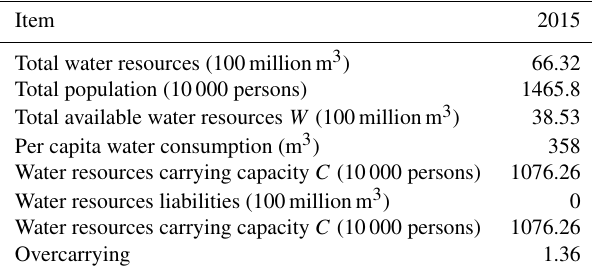
Table 4. Water resources carrying capacity of Chengdu in